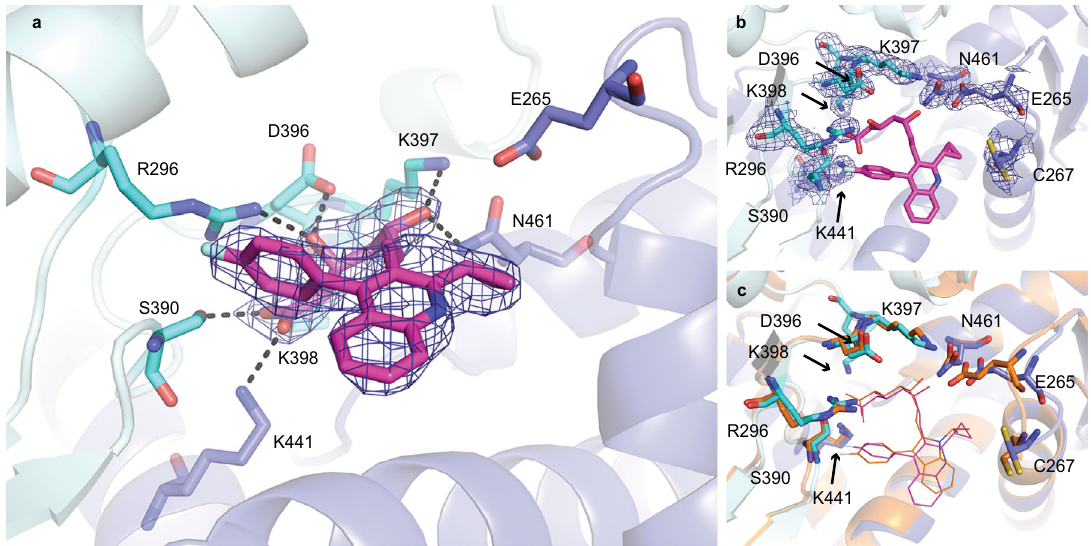
Fig. 3 | AtHMG1 E265 does not hydrogen bond with statins. a AtHMG1 with pitavastatin(magenta)bound.Residuesthathydrogenbond(dashedblacklines)to theHMGmoietyofstatinsinAtHMG1areshown(blue/cyansticks). b AtHMG1(blue cartoon) with pitavastatin (magenta line) bound, active site-delineating residues labelled and shown as sticks with electron density. c AtHMG1 with pitavastatin